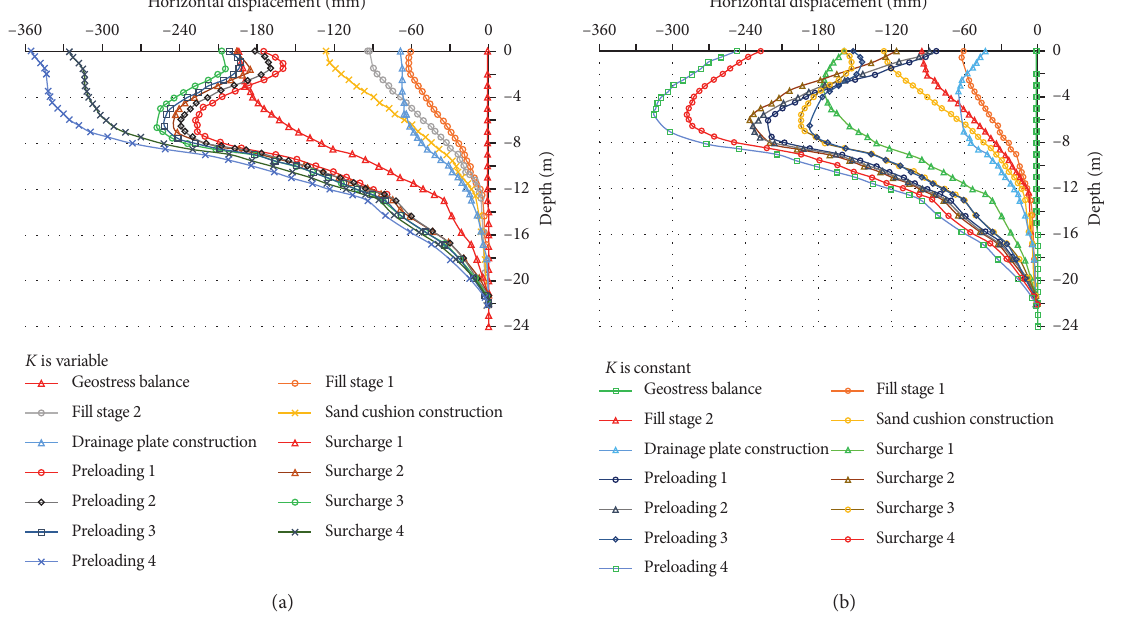
Figure 11: Horizontal displacement changes in